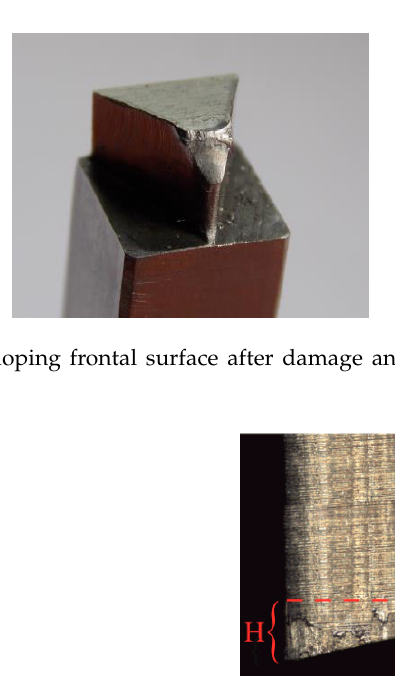
Figure 19. Tool after blanking about 63,000 elements with 5% clearance: ( a ) the principal blanking- punch elements; ( b ) cutting edge wear; ( c ) fatigue wear.